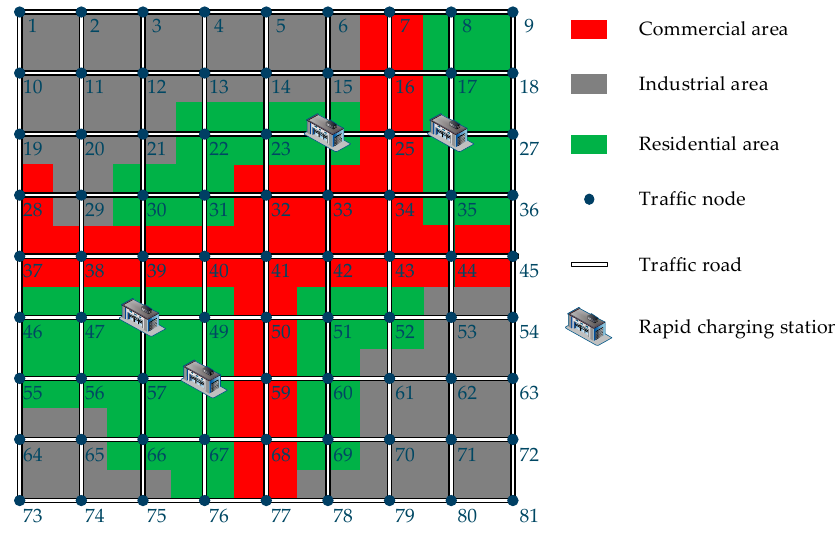
Figure 17. The siting results.